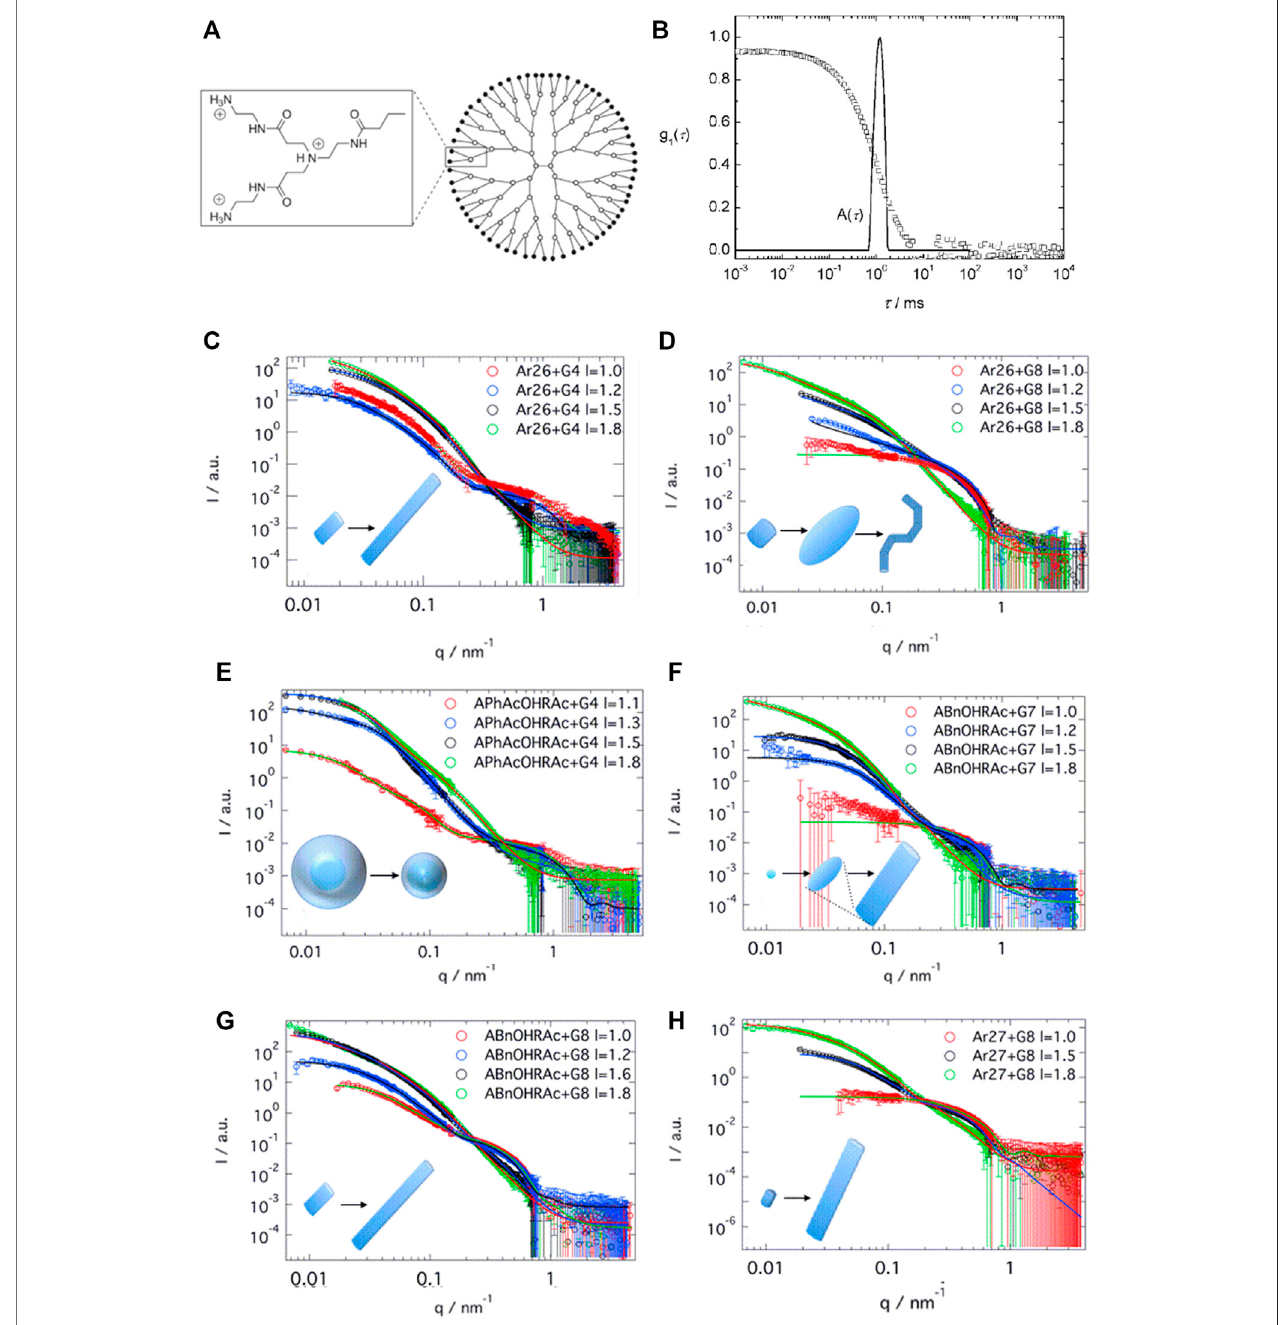
FIGURE 7 | Scattering analysis of a dendrimer dye model system for electrostatic self-assembly in solution: (A) Dendrimer structure; (B) Dynamic light scattering (DLS):electric fi eldautocorrelationfunctionanddecaytimedistributionatascatteringangle θ (cid:1) 90 ° forAr44-G4dendrimerwitharatiol (cid:1) 2.1(Willerichetal.,2009); (C – H) SANS and resulting nanoparticle shapes as a function of dye type, dendrimer generation and loading ratio: SANS results for (C) Ar26 + G4, (D) Ar26 + G8, (E) APhAcOHRAc + G4, (F) ABnOHRAc + G7, (G) ABnOHRAc + G8, and (H) SuACAc + G8, each at varying loading ratio. Continuous lines represent the best structural fi t (Mariani et al., 2016a). Reprinted with permission. Copyright © 2008 and 2015 American Chemical Society.